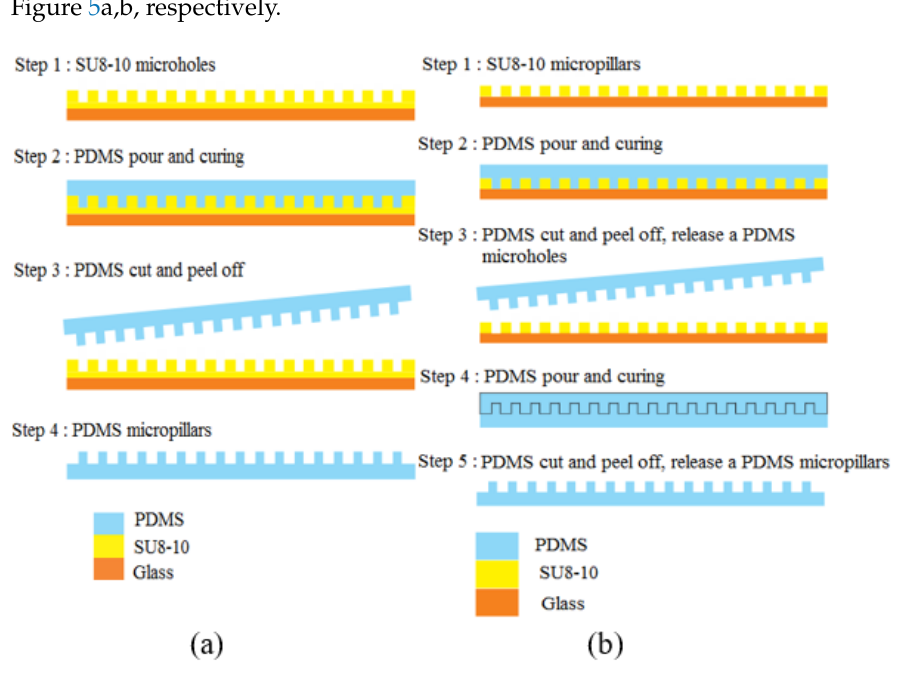
Figure 4. Fabrication steps of SU8 micropillar using ( a ) SU8-10 microhole mold, and ( b ) PDMS microhole mold (PDMS–PDMS pattern transfer).